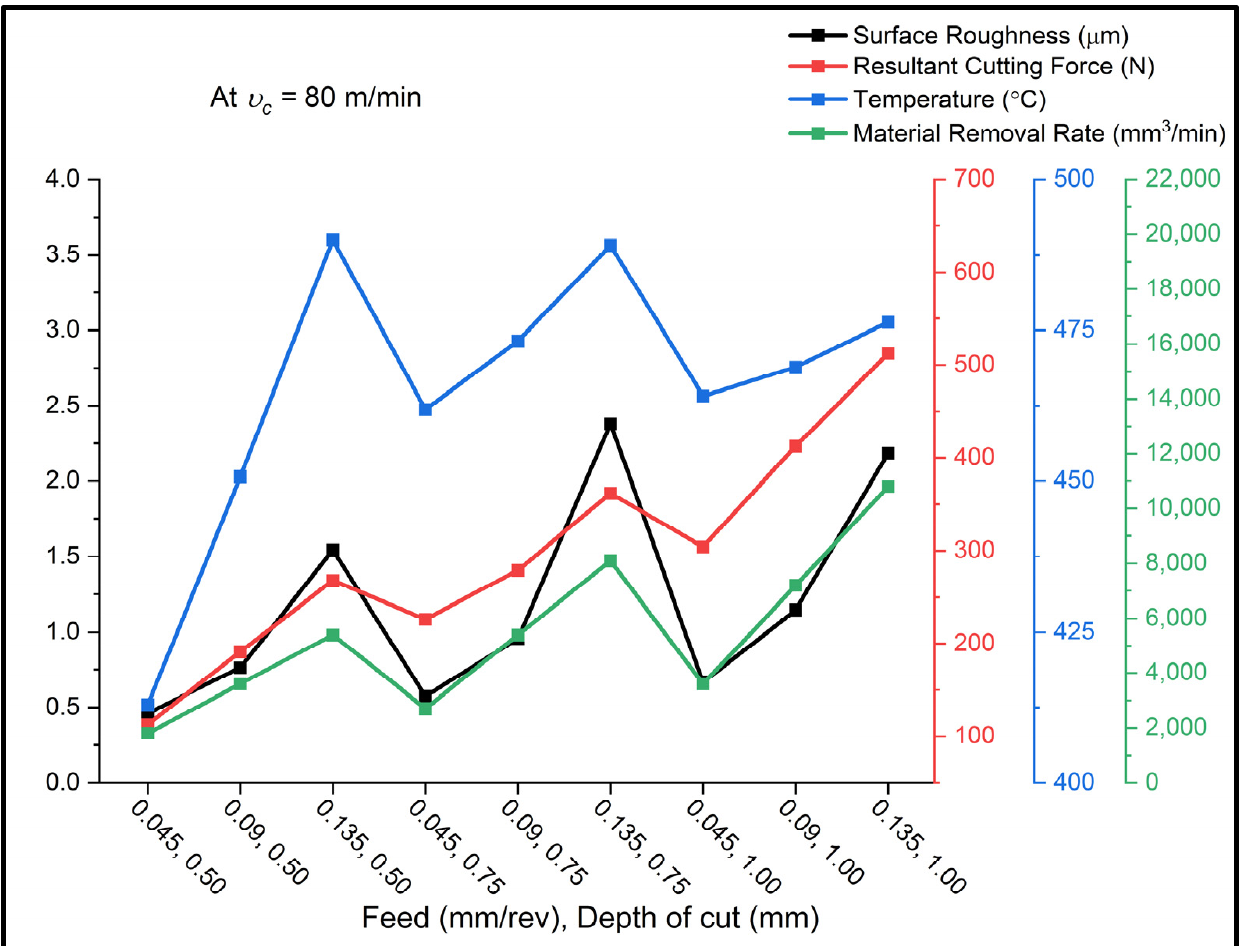
Figure 10. The experimental results at cutting speed = 80 m/min.